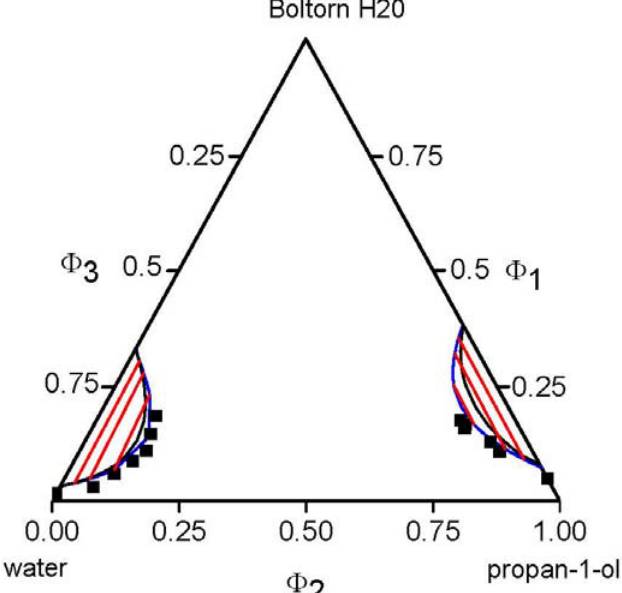
Figure 10. Experimental (squares, [56]), predicted using LCT with the parameters in Table 6 (black lines, [56]), and fitted via changing the value for the binary interaction of water and propan-1-ol from 64 K to 45 K (blue line, [56]) ternary phase behaviour of Boltorn H20 + water + propan-1-ol at 353.15 K. The red lines are tie lines which are calculated with ∆(cid:2013) (cid:2869)(cid:2870)(cid:3013)(cid:3004)(cid:3021) /(cid:1863) (cid:3404) 45 (cid:1837) (cid:3003)